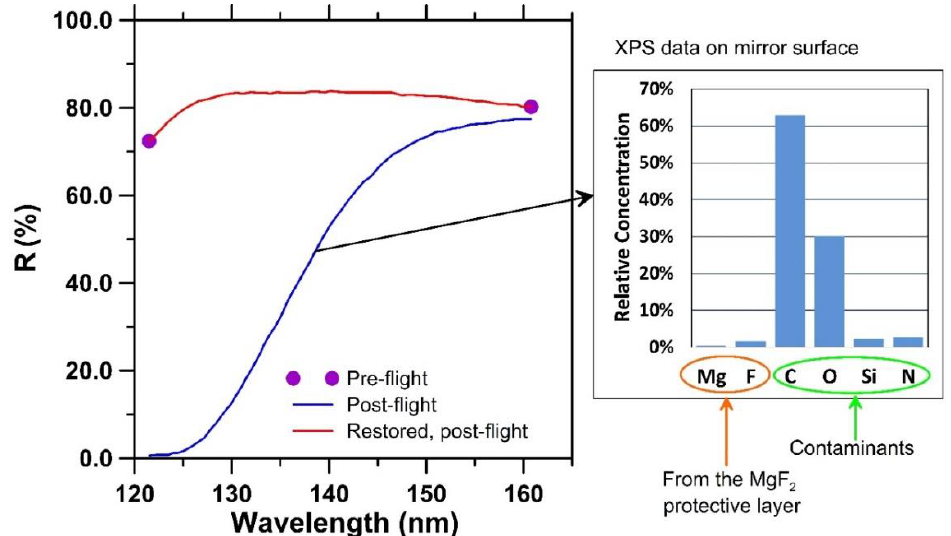
Figure 2. Evolution of the far-ultraviolet reflectance of the Wide Field and Planetary Camera-1 (WFPC-1) pick-off mirror (based on Al protected with MgF 2 ). Purple points: pre-flight data. Blue: post-flight data after 3.5 years of deployment in space, with a severe reflectance degradation. Red: reflectance recovery after contamination removal with a chemical cleaning. The inset on the right depicts XPS data acquired on the surface of the recovered mirror after its return to Earth, showing the presence of contaminants such as C, O, Si, and N. [95].